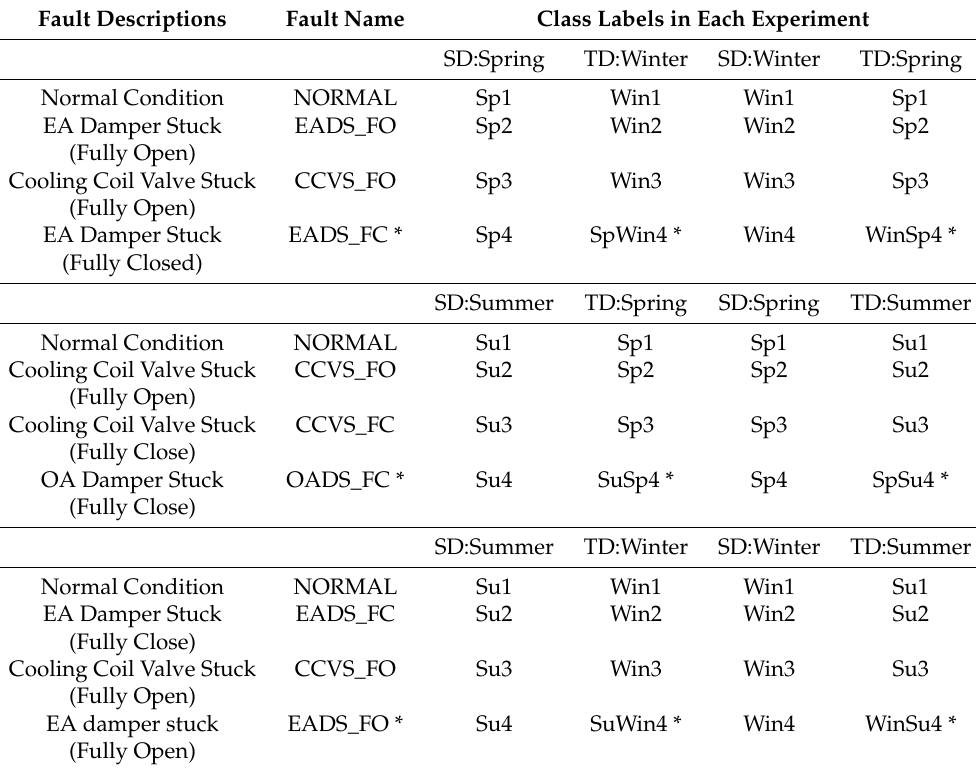
Table 1. Multi-Labeled Fault Data Selected for Each